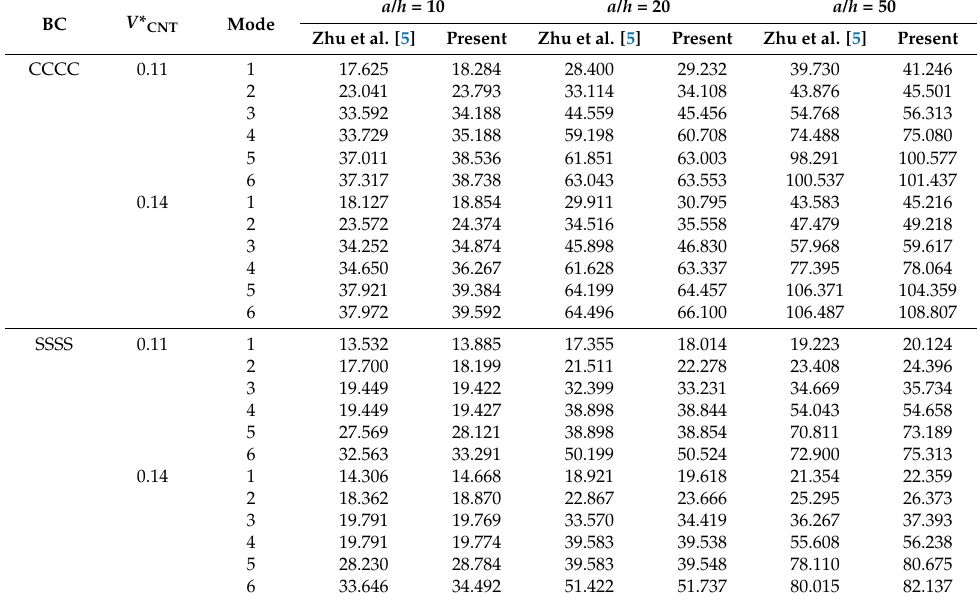
Table 5. Comparison study of first six non-dimensional frequency parameter of UD CNT-reinforced composite